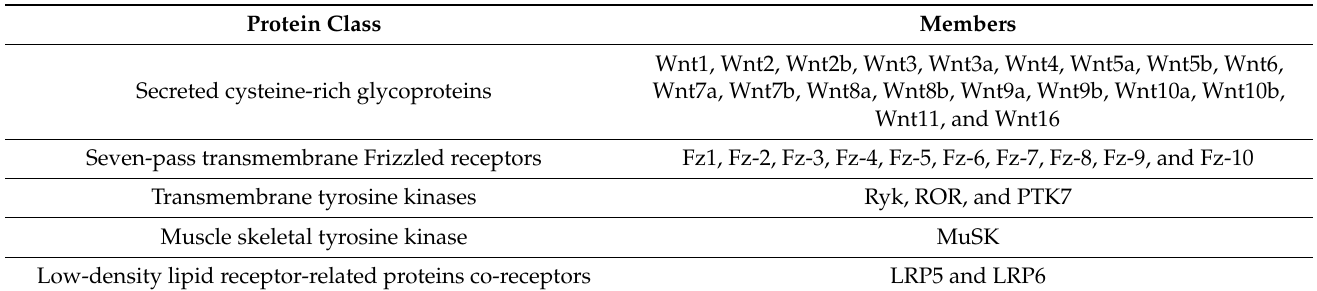
Table 2. Summary of the Wnt protein family